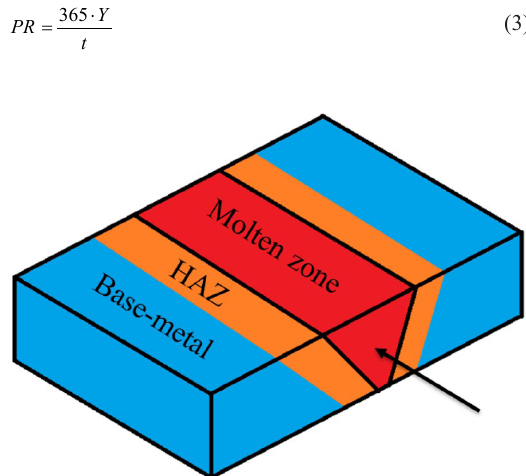
Figure 3. Schematic representation of the pitting corrosion susceptibility test specimen. The black arrow represents the face observed in the results section.